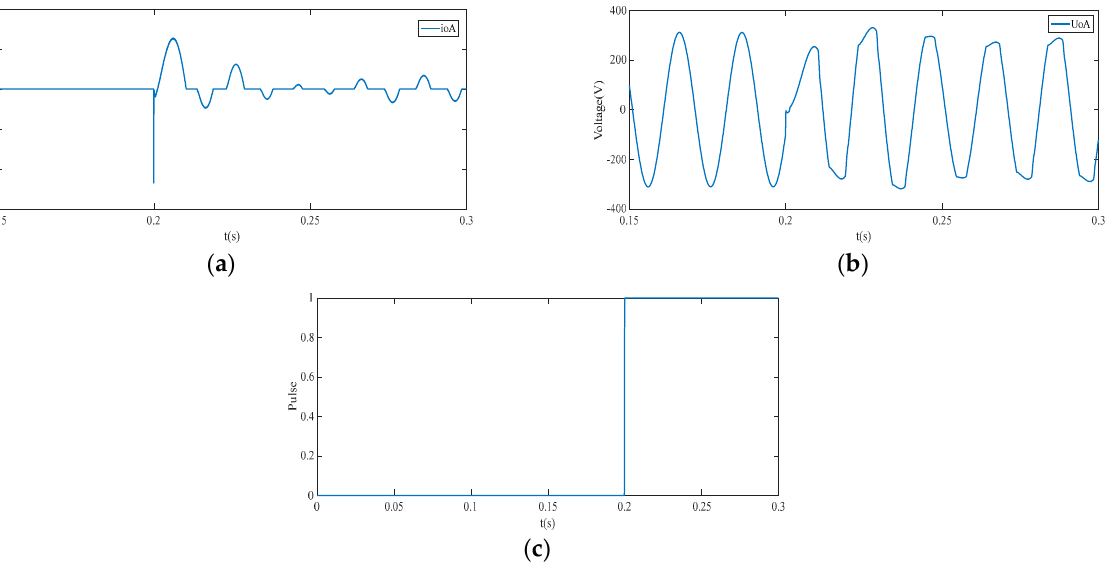
Figure 7. Simulation results of UPS with rectifier load using current limiting method ( a ) output current of phase A, ( b ) output voltage of phase A, ( c ) load pulse. current of phase A, ( b ) output voltage of phase A, ( c ) load